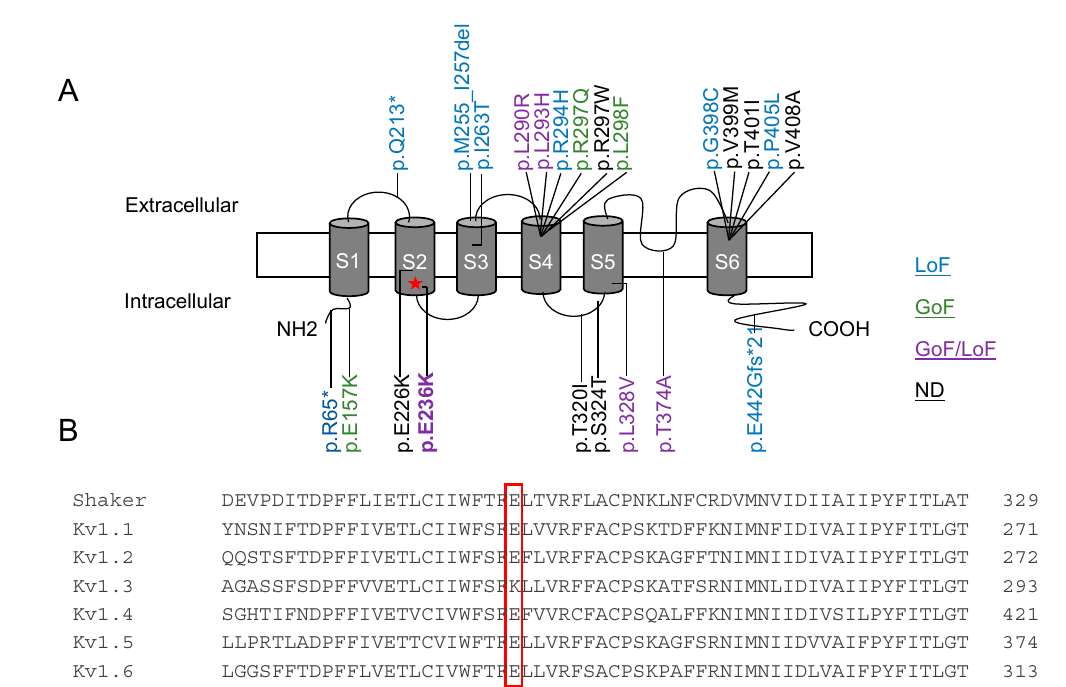
Figure 2. ( A ) Position of identified mutations in the Kv1.2 channel structure and localization of the E236K variant. ( B ) Amino acid alignment of Kv1 channels. LoF, loss-of-function; GoF, gain-of-function; ND, not detected.